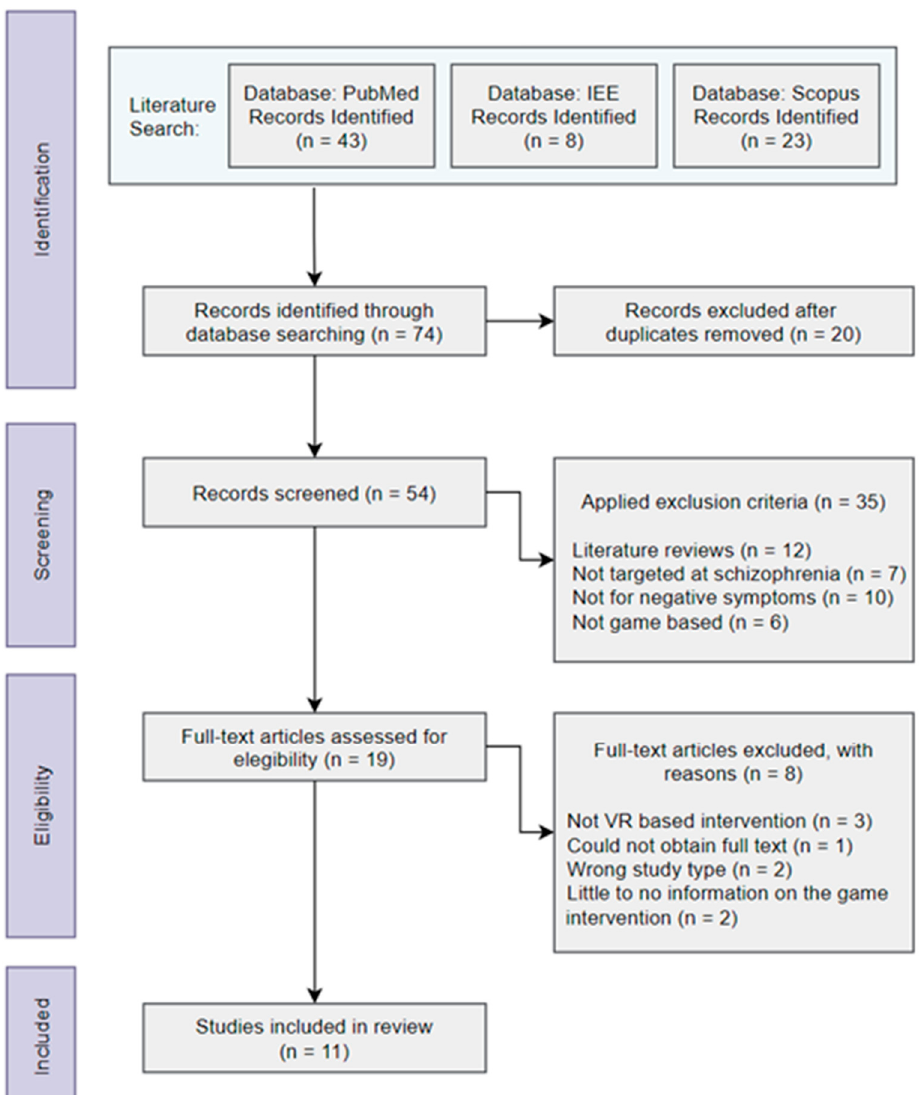
Figure 1. Steps followed to collect and select articles for revision.